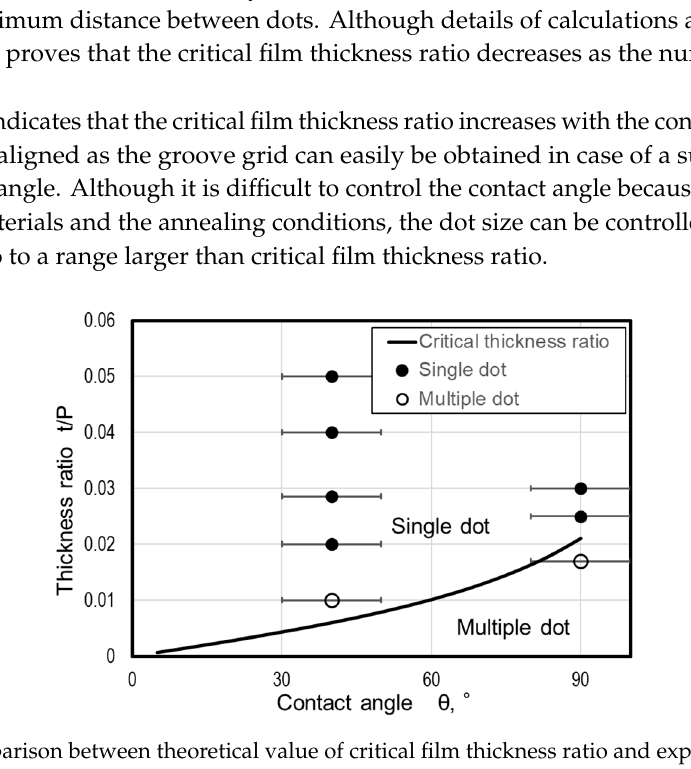
Figure 8. Comparison between theoretical value of critical film thickness ratio and experimental value of dot formation.